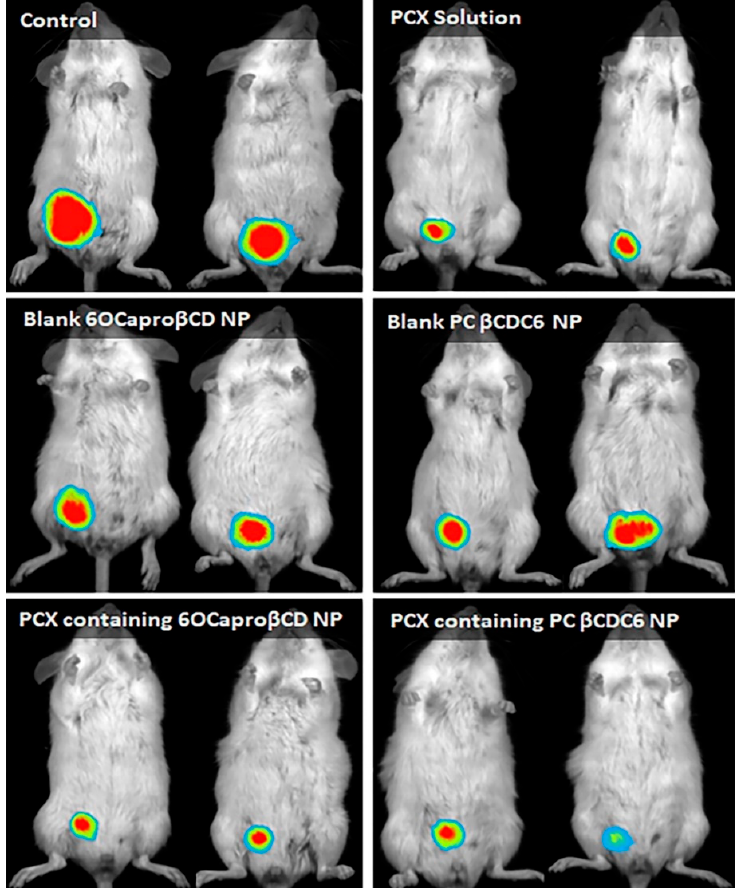
Figure 9. Visualization of the tumor mass on day 14 of the in vivo studies. The 4T1-Red-FLuc tumors were monitored with D-luciferin (150 mg/kg, Biovision) injection intraperitoneally (left colon day 0, right column day 8). Mice were anesthetized, and luciferase activities were recorded in an in vivo imaging system. In our previous studies, it was observed that blank amphiphilic CD derivatives cause a selective antiproliferative effect in various cancer cells (MCF-7, HepG2, MDA-MB-231), although they do not have any toxic effects on healthy fibroblasts (L929) and healthy bladder cells (G/G1) [33]. With advanced cell culture studies performed with proteomic and metabolomic approaches, it was determined that this effect was caused by the cholesterol affinity of CDs [32]. It is known that amount of cholesterol in the mem- branes of cancer cells is higher than that in healthy cells. Moreover, the cholesterol con- tent in the membrane also varies according to the drug resistance of the cancer. Todor et al. reported that the amount of cholesterol increased by 60% in resistant MCF-7 cells [47]. CDs are also used to manipulate the cholesterol composition in different cells in the lit- erature. In our previous study, the effects of blank 6OCapro β CD nanoparticles on MCF-7 cells were investigated by biochemical and proteomic tests. According to the results of the proteomics studies, it was determined that the protein levels of Heterogeneous nu- clear ribonucleoproteins (hnRNP) and chromobox protein (CBX1) associated with apop- tosis were increased, and hepatoma-derived growth factor (HDGF) was not affected. In